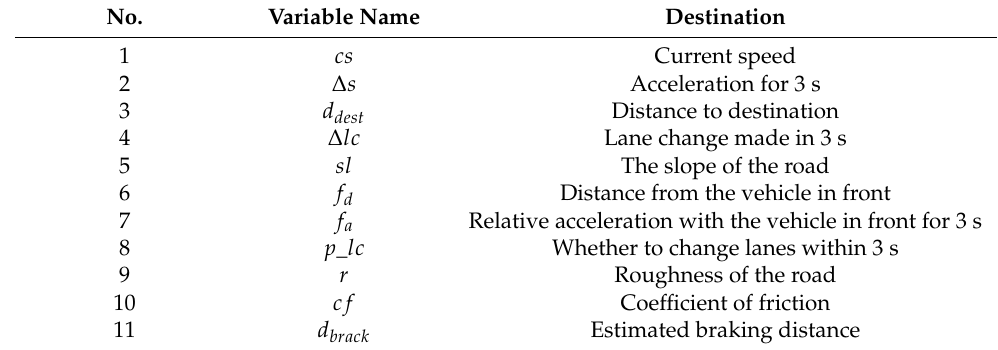
Table 2. Input data set of the BPCS.